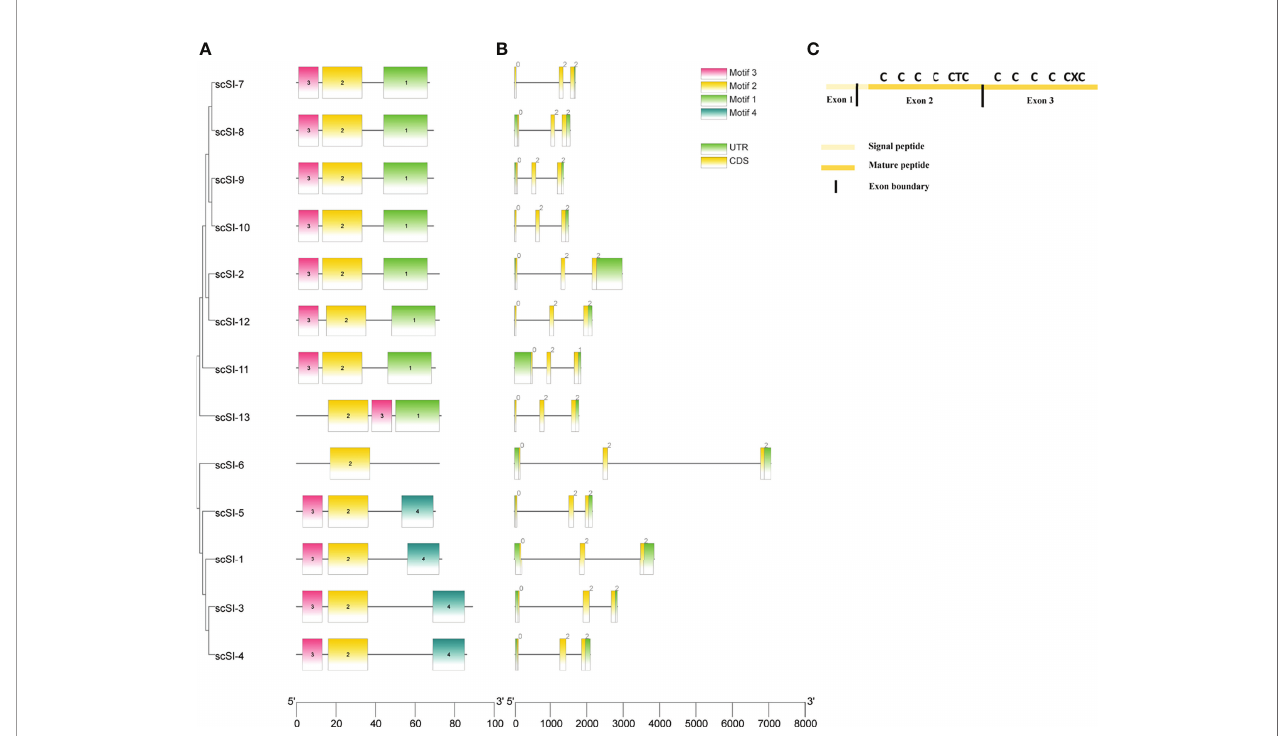
FIGURE 3 | Mature polypeptide motifs and gene structure for all Family I84 genes excluding the scSI-14. (A) Polypeptide motifs of these gene members, different color blocks are motifs and the 1,2,3,4 in the block represent the number of motif. Motif 1: QCQRGWHCIDGACHCGFDINGGG, Motif 2: CDAGHTVTCVRGQCTCTDPIQ, Motif